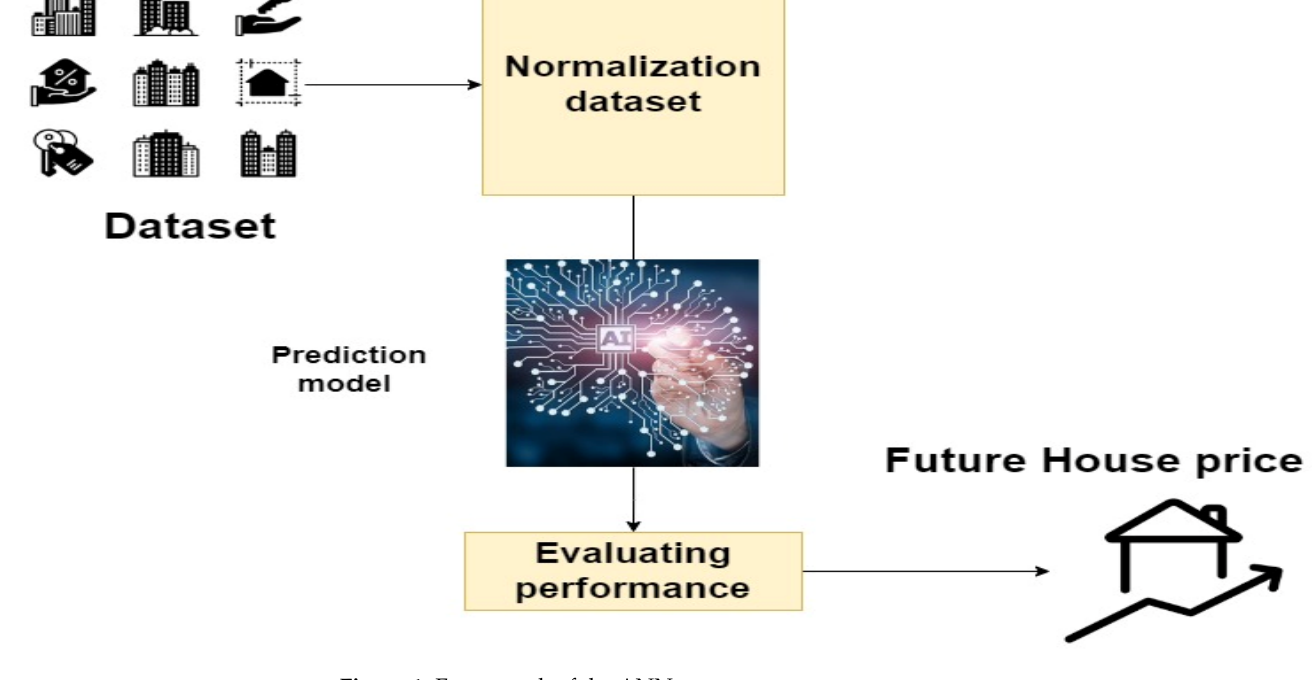
Figure 1. Framework of the ANN.